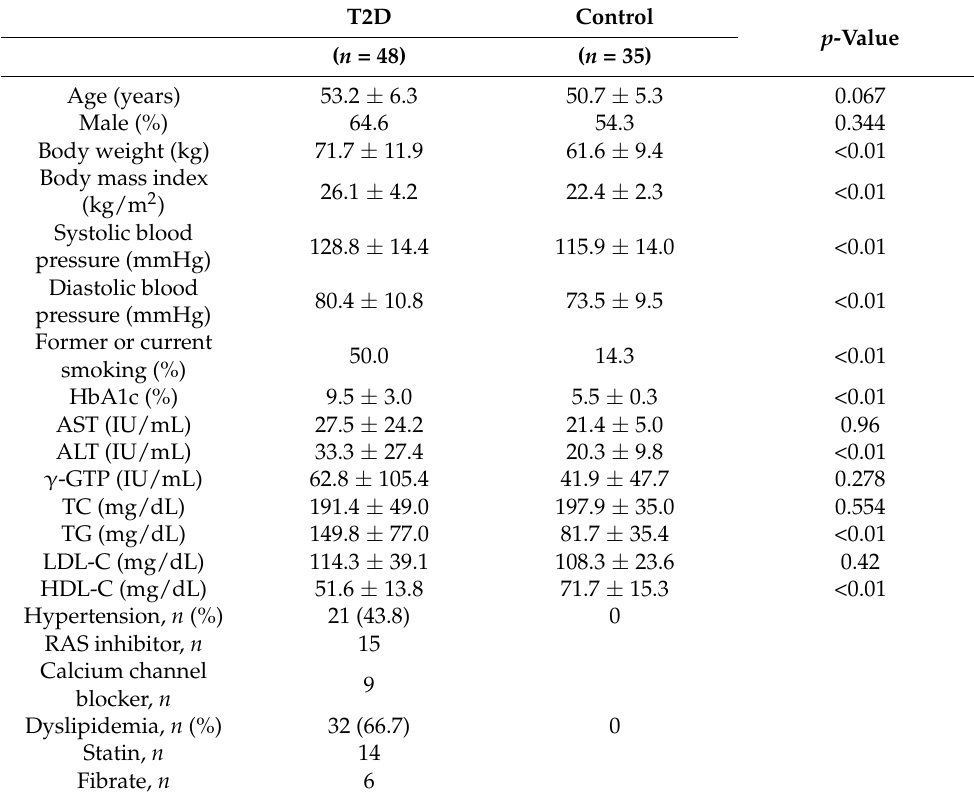
Table 1. Clinical characteristics of